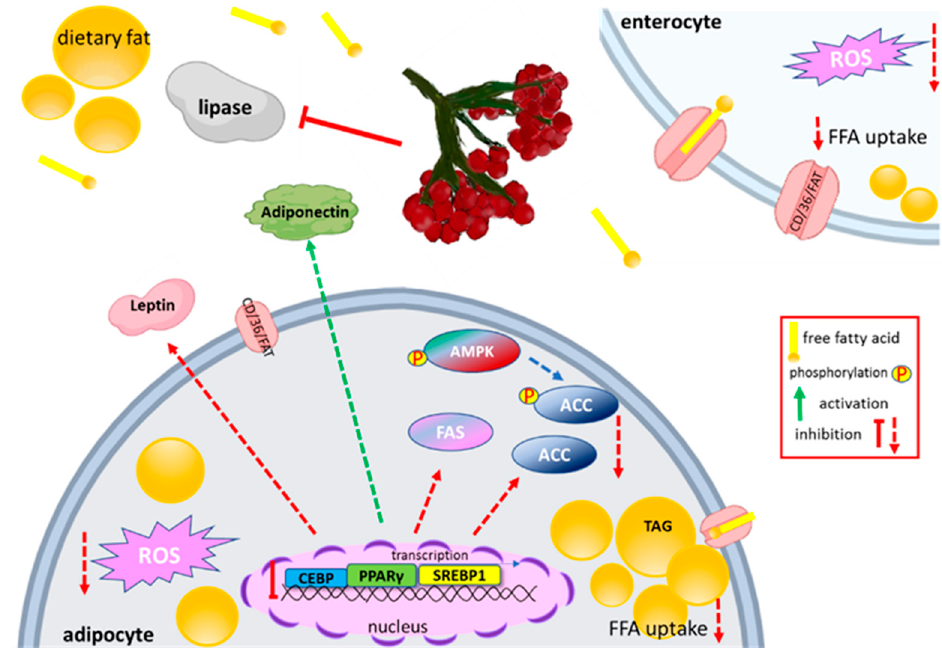
Figure 3. Viburnum opulus as adipogenesis process inhibitor; see the main text for more details. ACC—